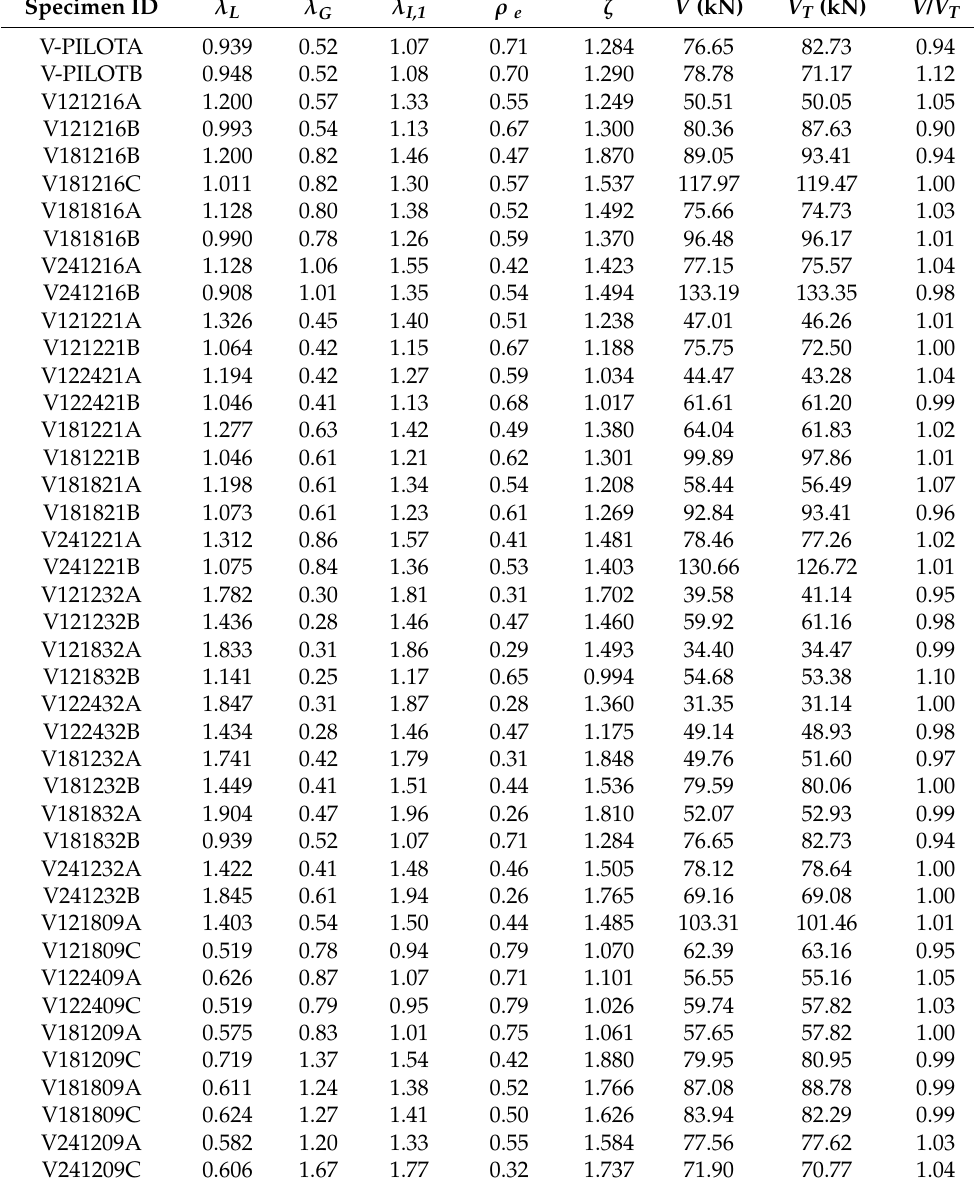
Table A11. Analysis result of test specimens reported by Elgaaly et al. [2].